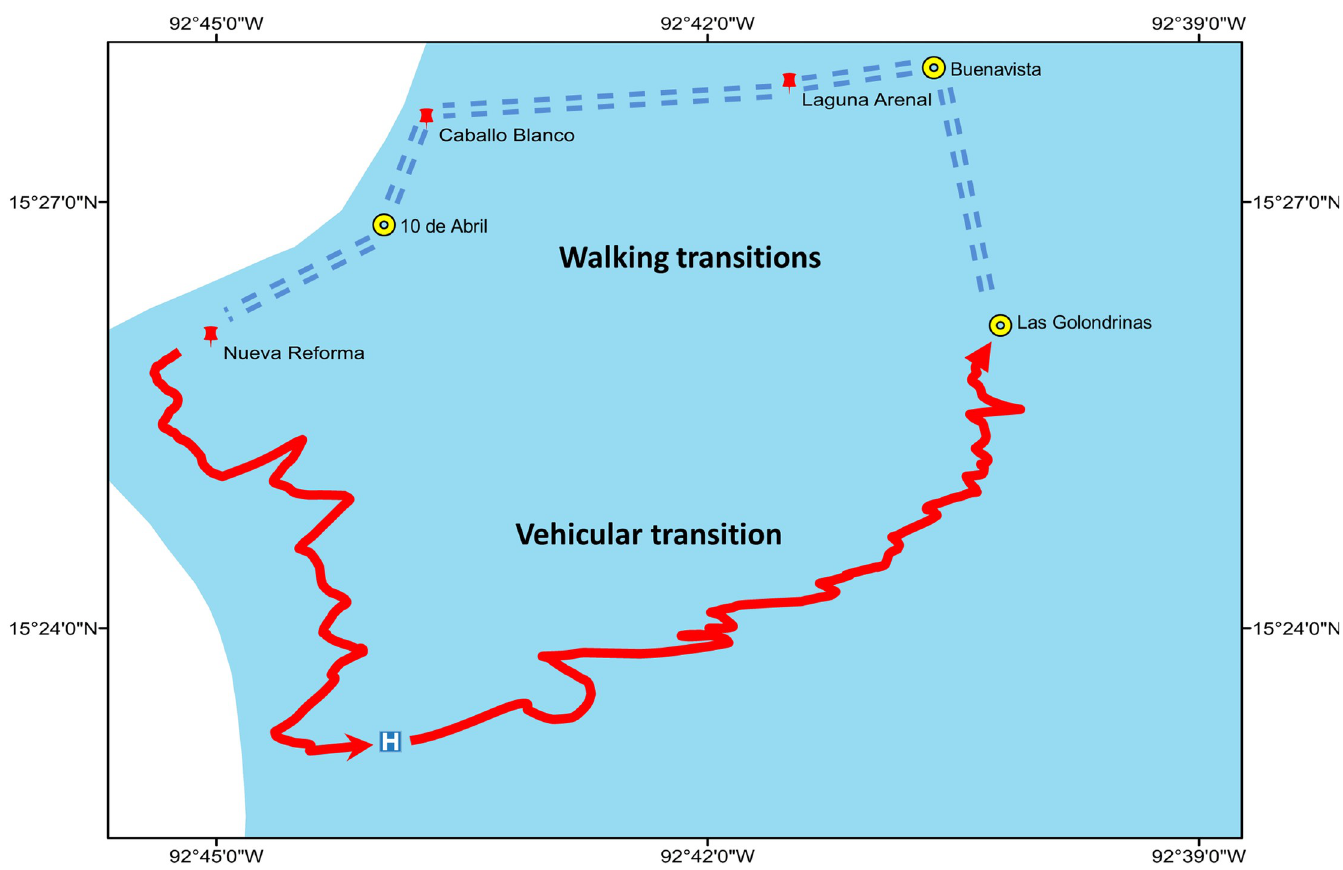
Fig 2. Map showing the walking and vehicular transitions taken for onchocerciasis brigades to reach the three communities under study. Map of Fig 2 was created using ArcGIS software by ESRI (www.esri.com). ArcGIS and ArcMap are the intellectual property of Esri and are used herein under license. Copyright Esri. All rights reserved. For more information about Esri software, please visit www.esri.com.